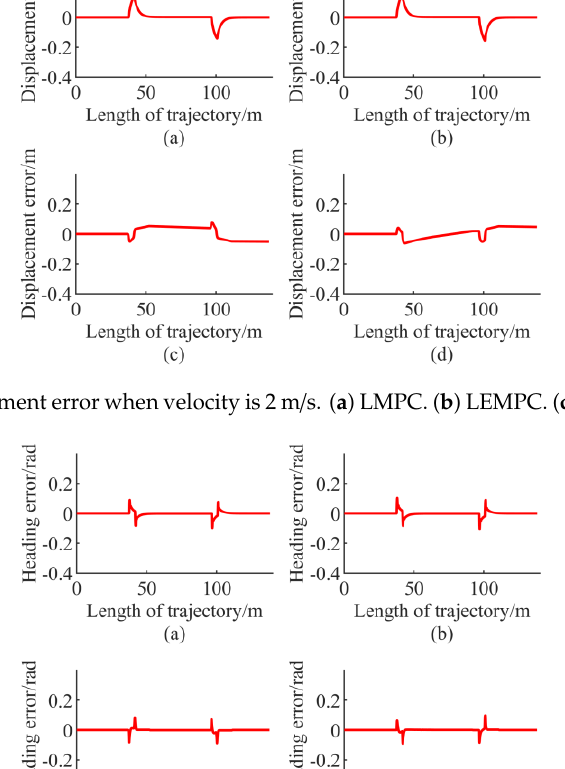
Figure 3. The heading angle speed when velocity is 2 m / s. ( a ) LMPC. ( b ) LEMPC. ( c ) NMPC. ( d ) NEMPC.